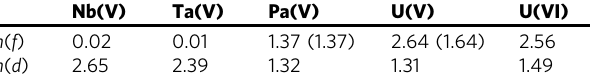
Numbers in parentheses re fl ect the difference to the formal occupations in oxidation state